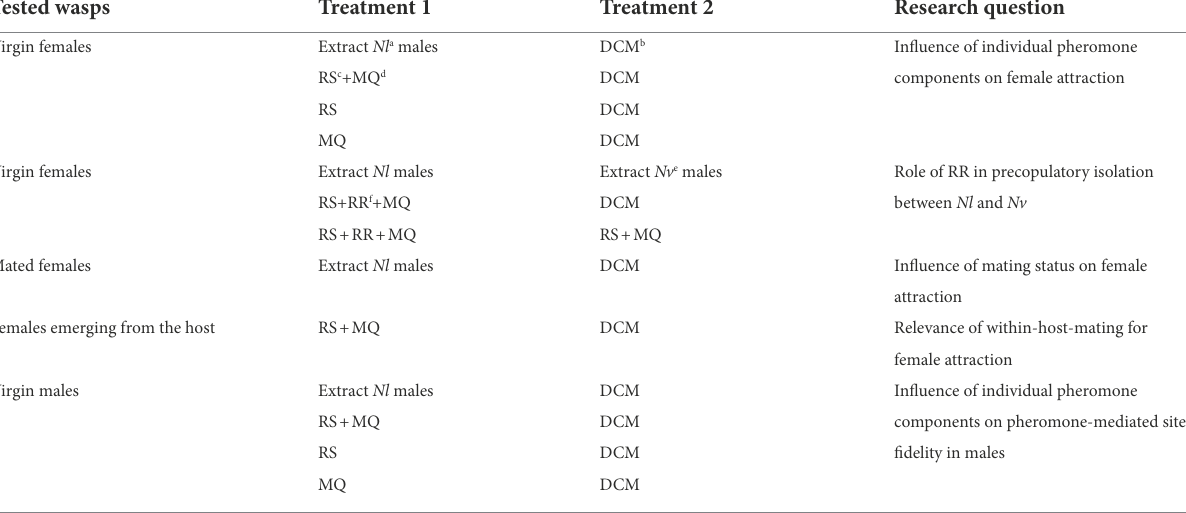
TABLE 1 Overview of the behavioral bioassays testing the responses of N. longicornis to natural extracts and synthetic pheromone components (for more details see text). Tested